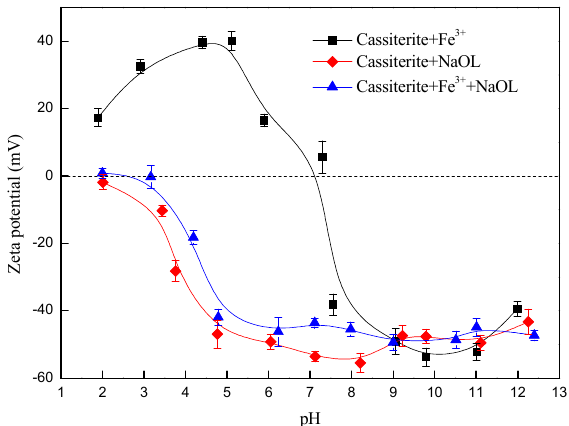
Figure 13. Zeta potential of cassiterite as a function of pH in the presence of Fe 3+ and/or NaOL (Fe 3+ : 8 × 10 − 5 mol/L; NaOL: 4 × 10 − 4 mol/L).